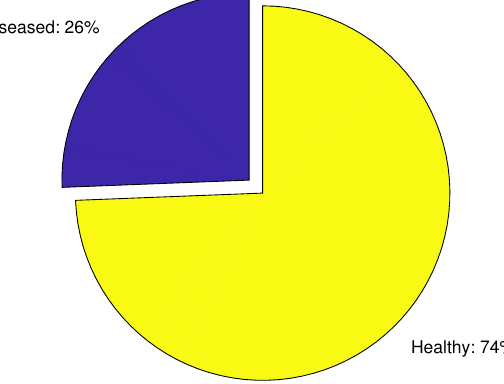
Figure 3. Distribution of the images before